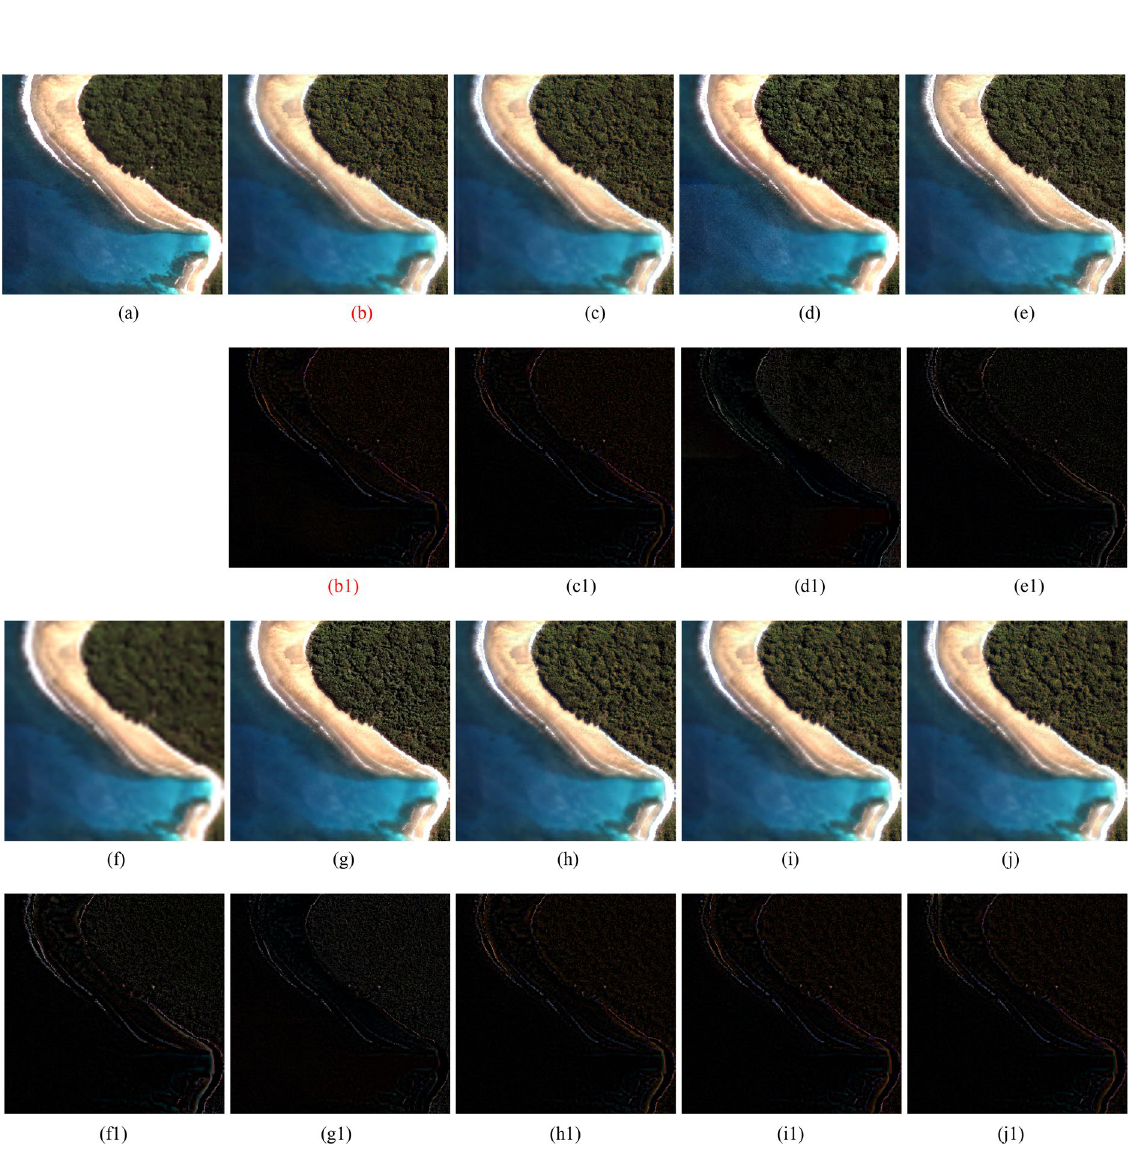
Figure 4. QuickBird images fusion results. ( a ) Ground truth. ( b ) GSA method. ( c ) CBD method. ( d ) BDSD method. ( e ) BF method. ( f ) MMMT method. ( g ) RBDSD method. ( h ) ASIM method. ( i ) DIM method. ( j ) Proposed method. ( b1 )-( j1 ) are the residual